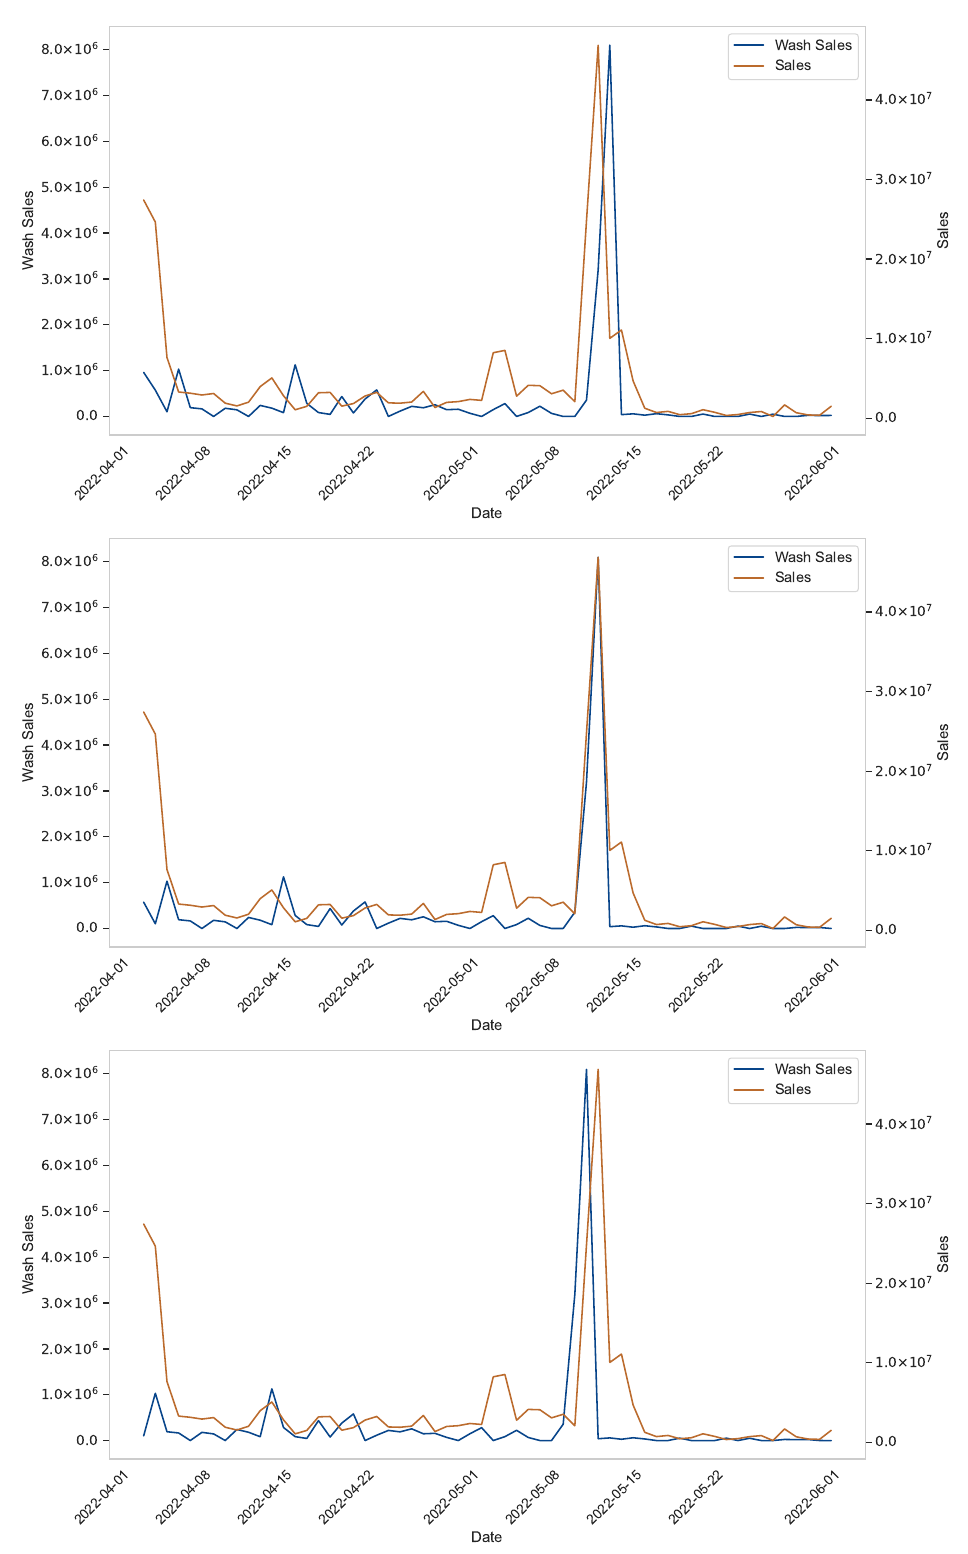
Figure 6. Cross-correlation of Wash Sales and Sales for Azuki when h = 0, h = 1, and h =